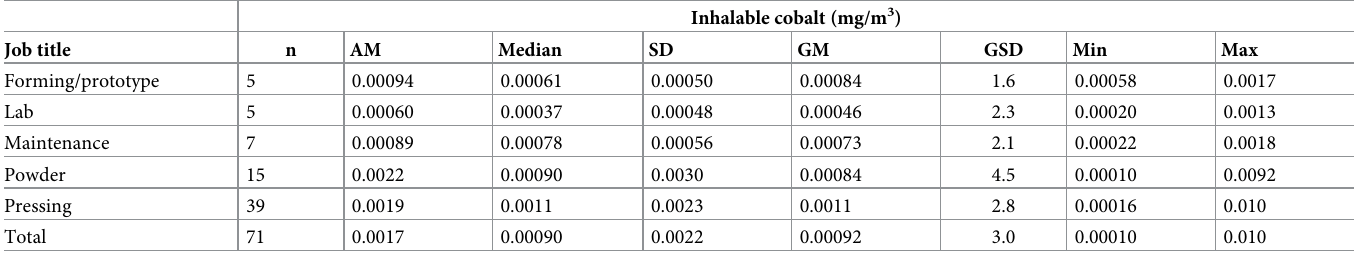
Table 3. Exposure concentration levels of inhalable cobalt by job title, adjusted for the use of